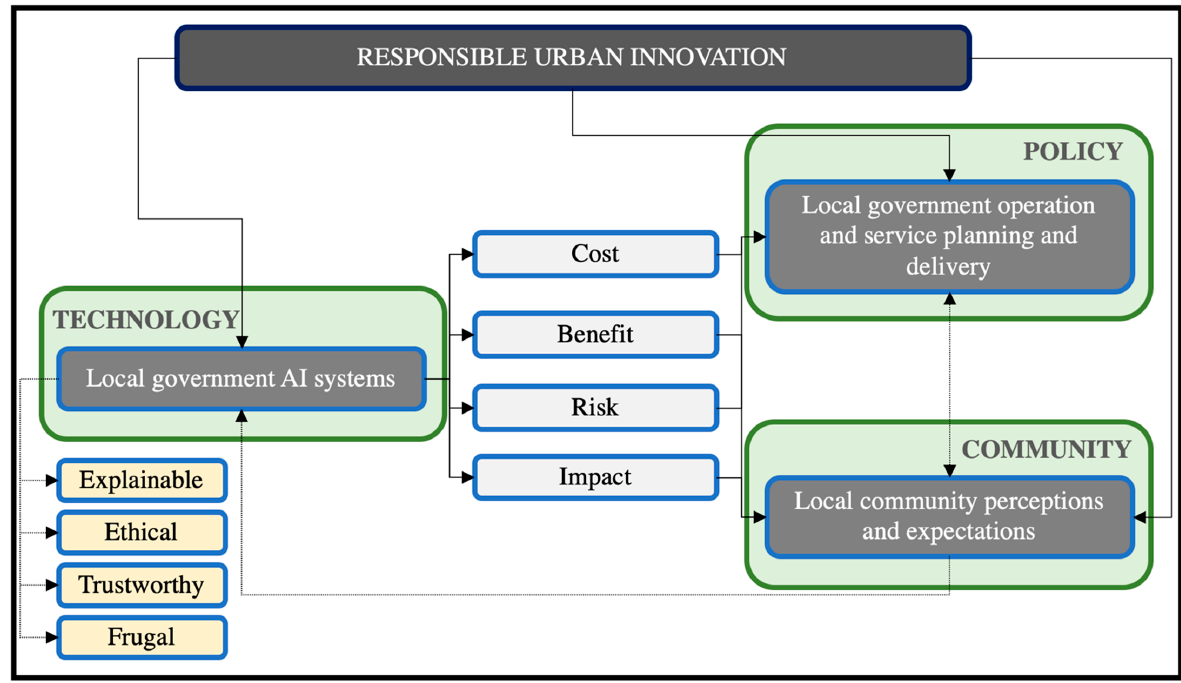
Figure 1. Conceptual framework of responsible urban innovation with local government artificial intelligence (AI).